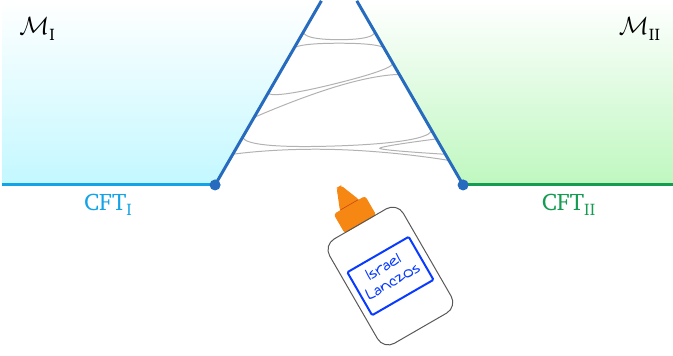
/ CFT . The two dark blue 3 2